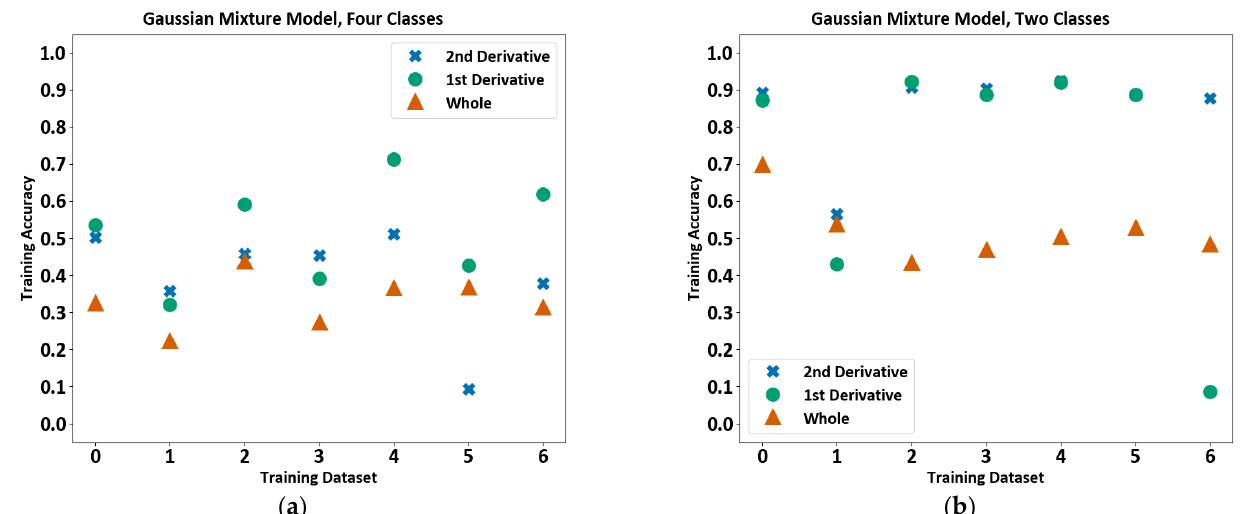
Figure 9. Gaussian Mixture Model training accuracy for each file using both the cooling period and derivatives of the cooling period. ( a ) The plot shows results for two classes, and ( b ) the plot shows results for four classes.